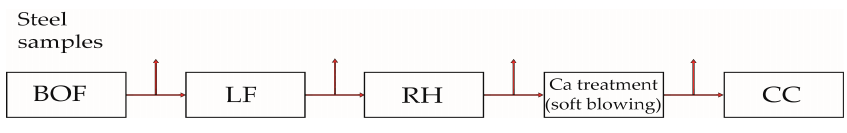
Figure 4. Schematic diagram of sampling locations.